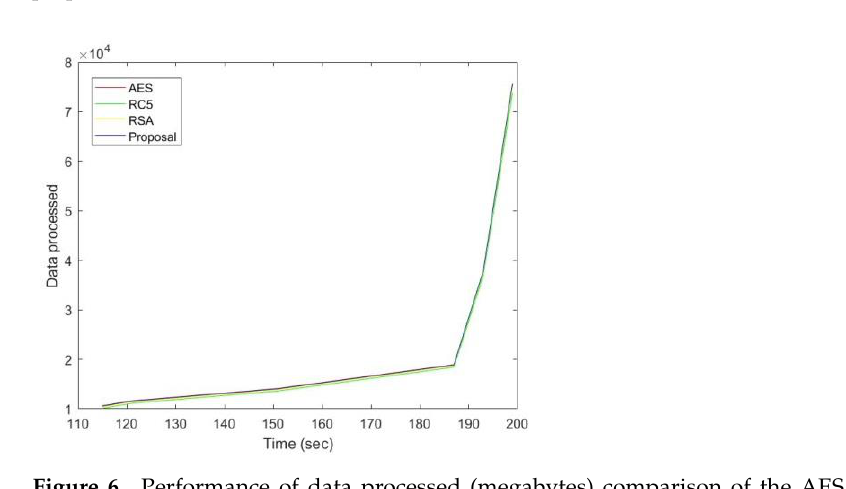
Figure 7. Performance of data processed (megabytes) comparison of the AES, RC5, RSA, and pro- posed model. 6. Comparative Analysis In addition to the literature review of past works presented in Section 2, we also re- viewed some other significant works in the specific field of CC and BD integration, with the aim of security. This section presents a comparative analysis of the related works that we have distinguished in the following paragraphs. Initially, we analyzed what each of them deals with, presented from the oldest to the most recent. K. Gai et al. [28] proposed D2ES, which is a new data encryption approach, focused on selective data encryption regarding privacy classification schemes under time limita- tions. S. K. Mishra et al. [29] proposed an algorithm with adaptive task allocation con- cerns that is used in heterogeneous Cloud infrastructures to decrease the makespan of Cloud infrastructure and achieve an energy-efficient environment. R Chaudhary et al. [30] proposed an SDN-based BD management scenario in regard to optimized network resource consumption, such as network bandwidth and data storage units. Finally, Y. Wen et al. [31] proposed MOPA in regard to the problem of scheduling workflow under security constraints, along with simultaneously reducing the execution time and the cost for BD applications in a Cloud infrastructure. Table 7 shows that most of the related works involved and tried to solve the chal- lenges related to Computation (Processing) and Analysis . Furthermore, most of the former